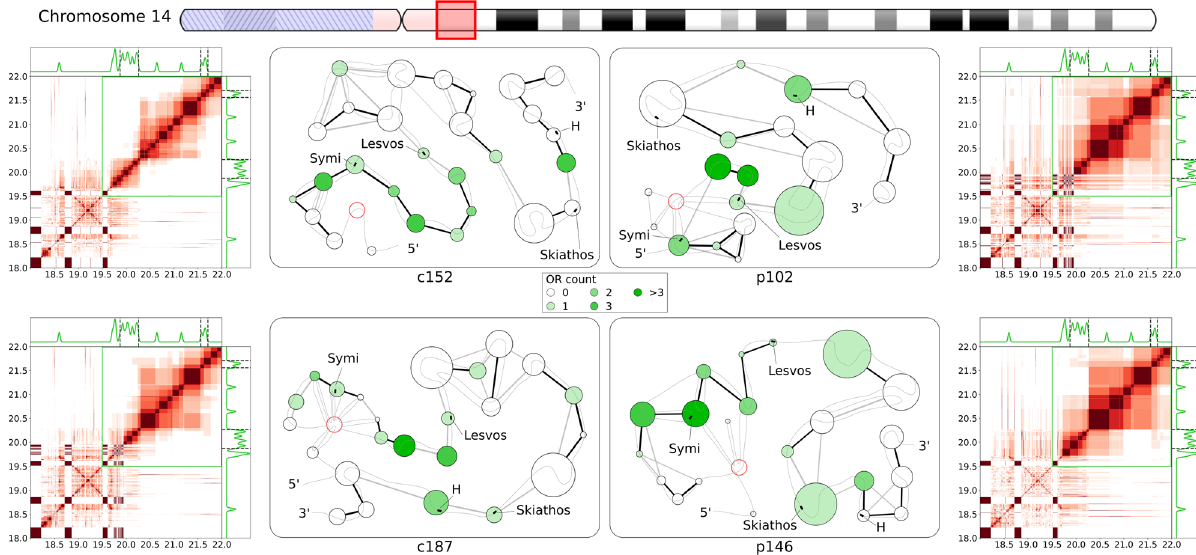
Figure 6. Fine structural organization in two Class II olfactory receptor gene clusters near the chromosome 14 centromere. Notations and marks are as in Fig. 4. Heatmaps of interactions and network representation are given for structural units in the region 18.0–22.0 Mb of chromosome 14. Two OR clusters with nearby PEs are present in this region: the cluster at 19.8–20.3 Mb contain PEs Symi and Lesvos, while the smaller cluster 21.5– 21.7 Mb is flanked by PEs Skiathos and H. In the network representation the large structural unit associated with pericentromeric heterochromatin is composed of multiple non-contiguous segments, and it is represented here by the single node with a red